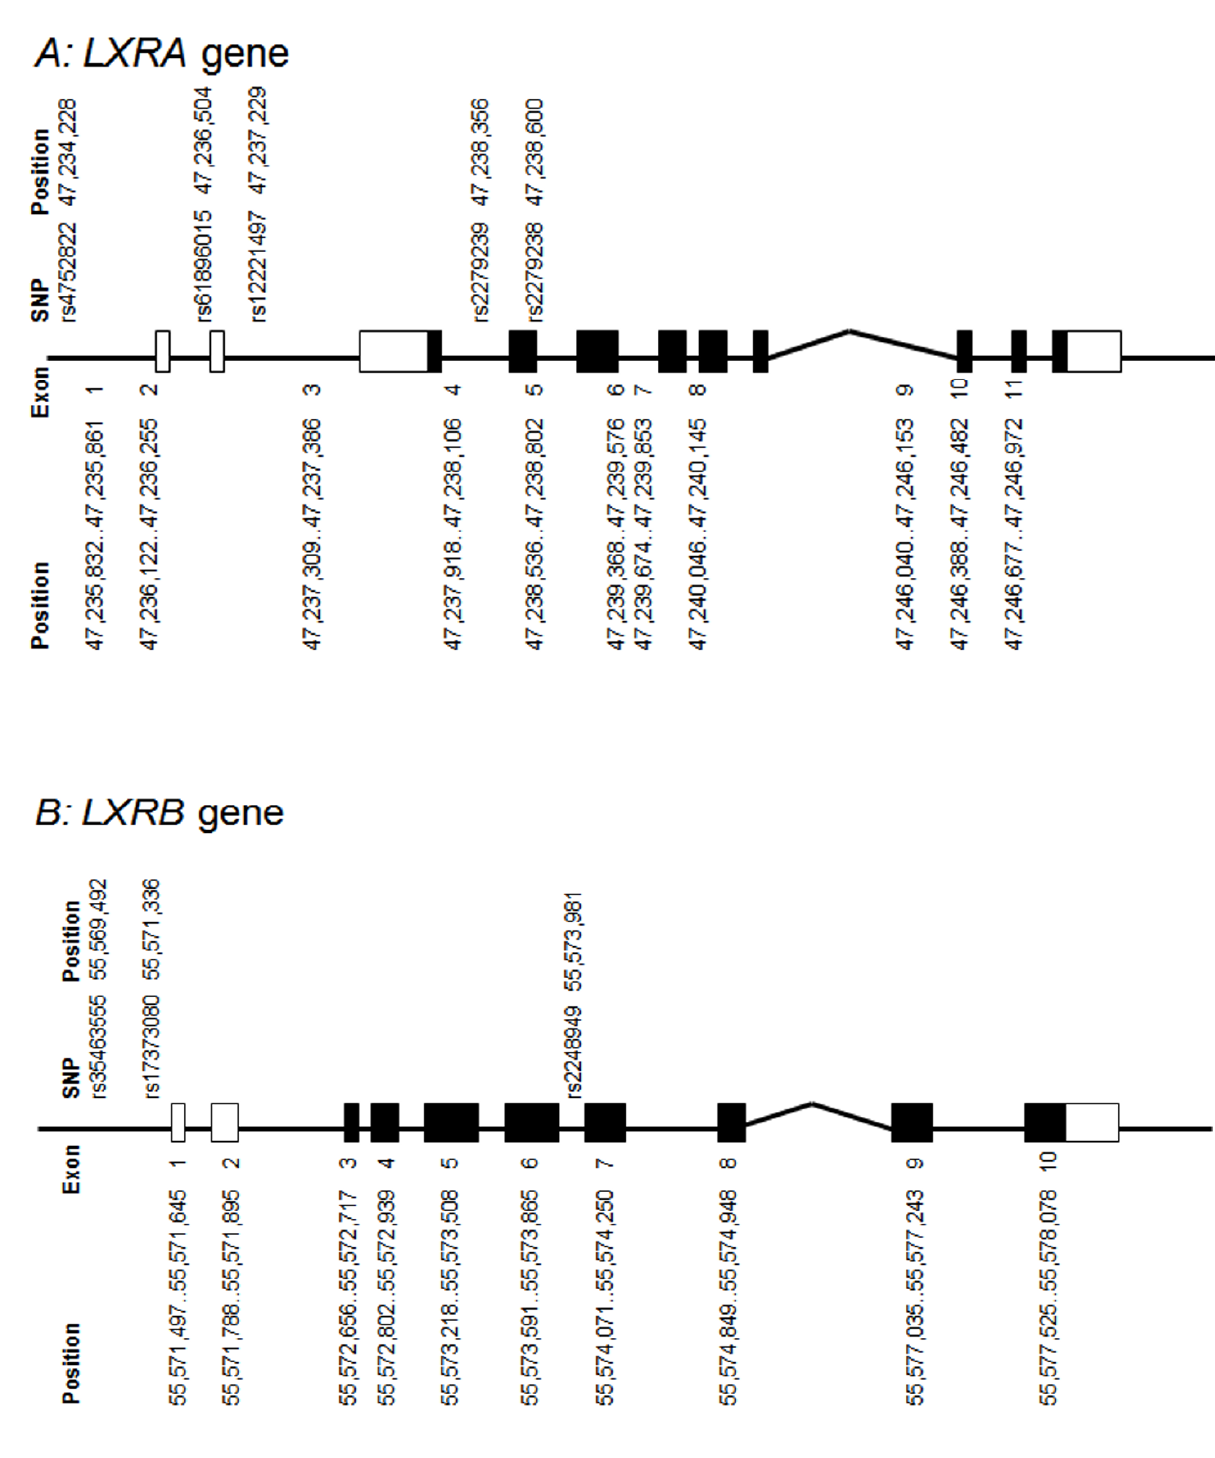
Schematic figure of LXRA and LXRB genes with position of genotyped SNPs according to NCBI as indicated